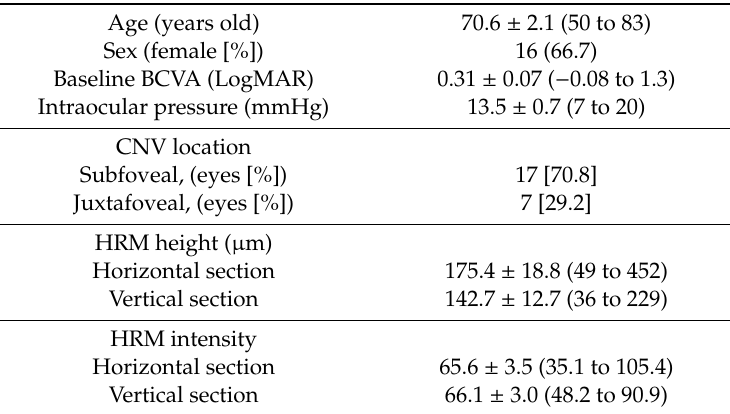
Table 1. Baseline characteristics of the